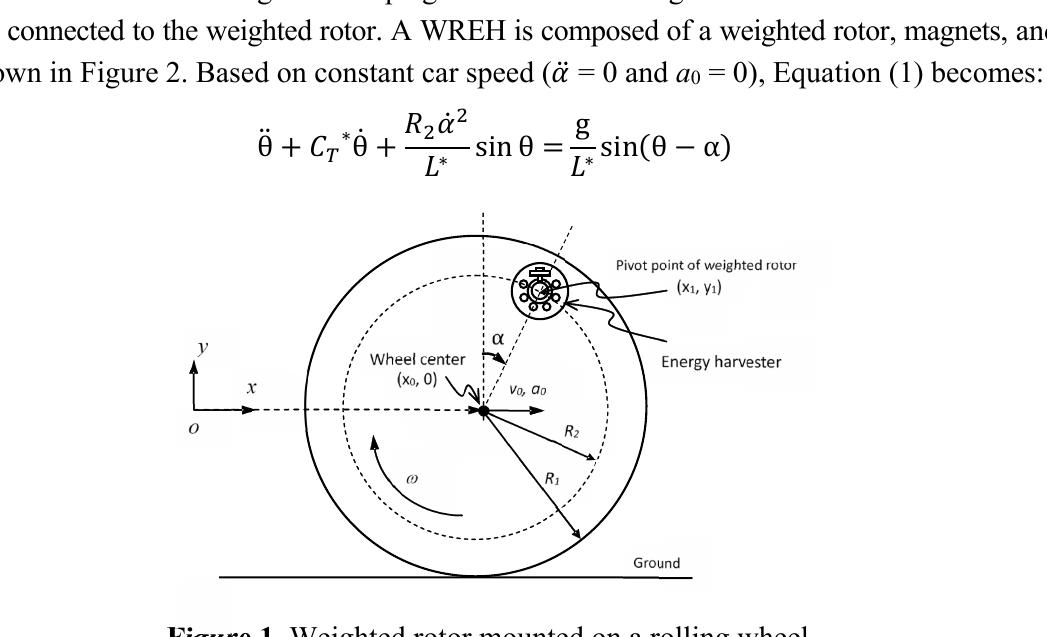
Figure 1. Weighted rotor mounted on a rolling wheel .